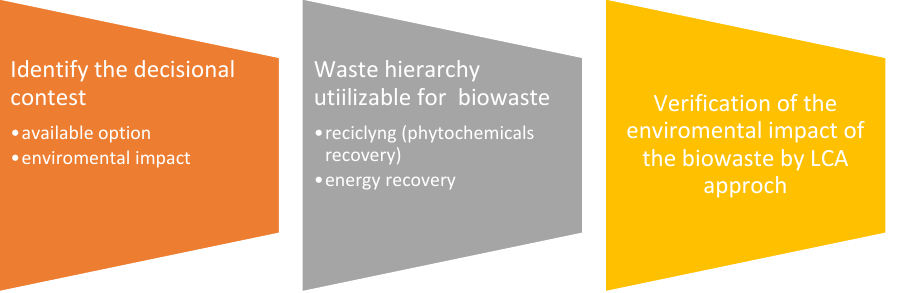
Figure 1. Methodological approach to finding the environmentally preferable option for bio-waste management.